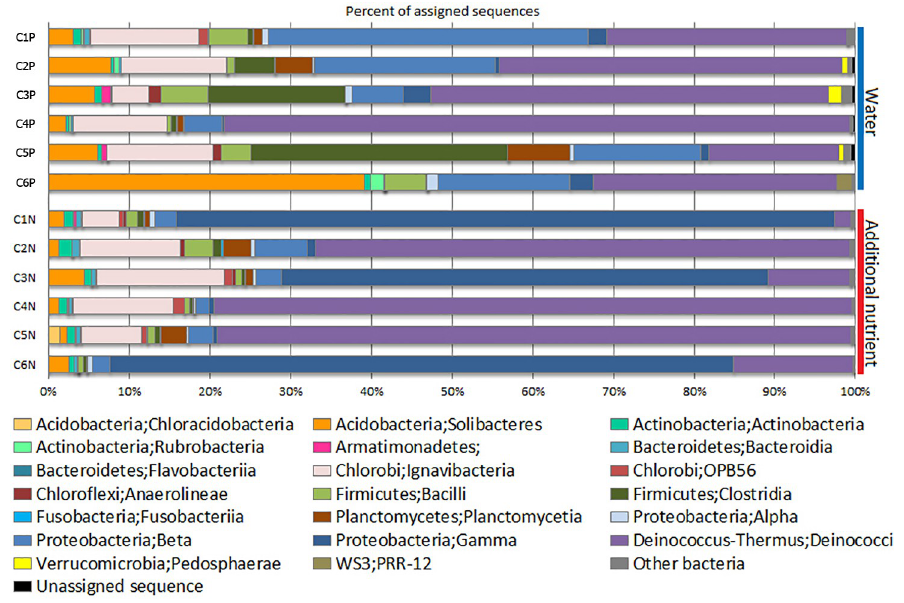
Fig 3. Class-level classification of bacteria in the control and the nutrient-treated sandstone core